Question: Reading the figure, is the described quantity rising or falling?
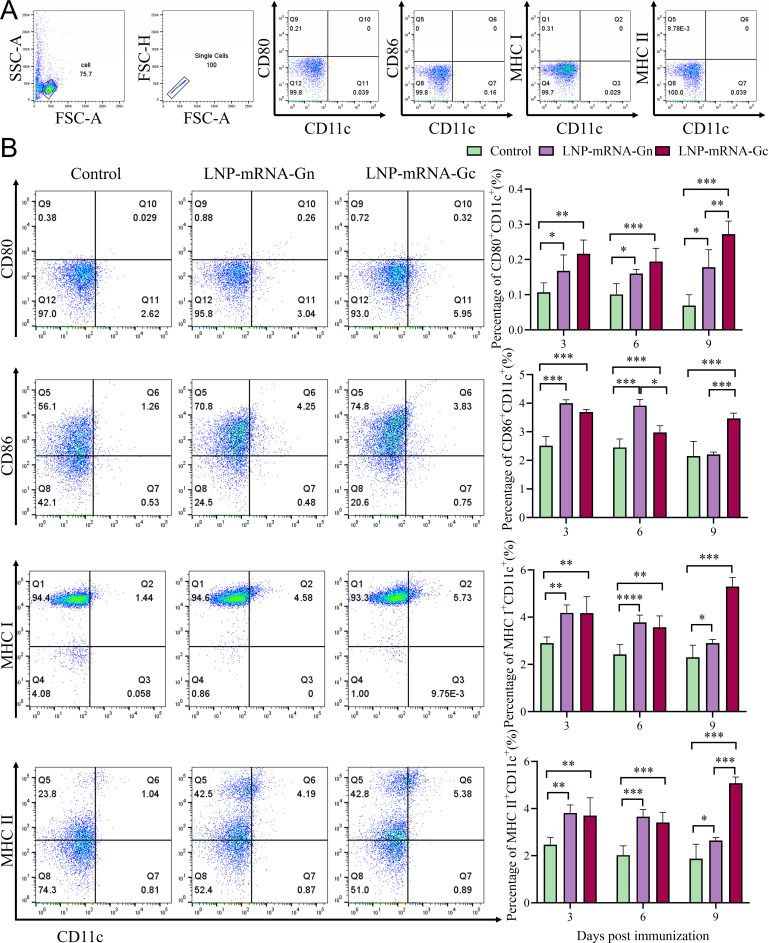
Answer: increasing